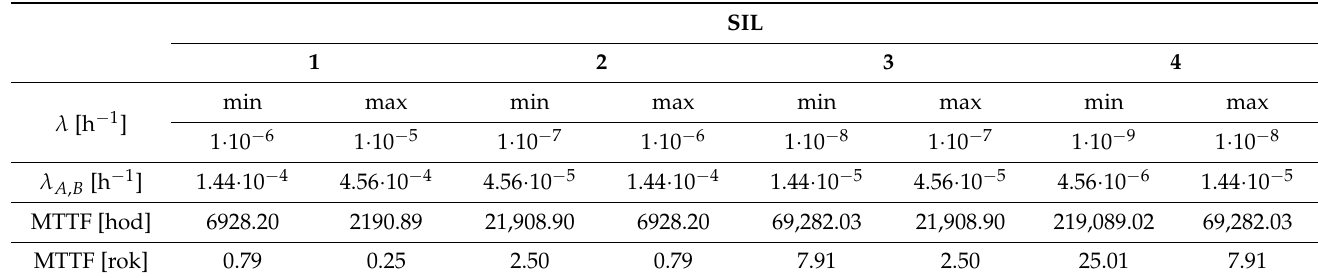
Table 2. The minimum failure rates and MTTFs of channels A and B necessary to achieve SIL 1–4 for fault detection and negation time of 24 h determined according to Equations (4) and (6).